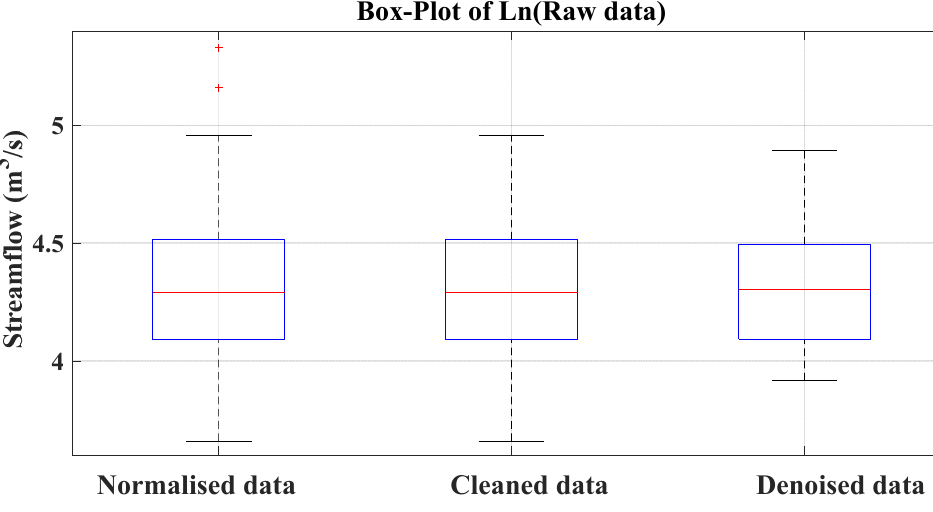
Figure 5. The normalized, cleaned, and denoised data box plot distribution.